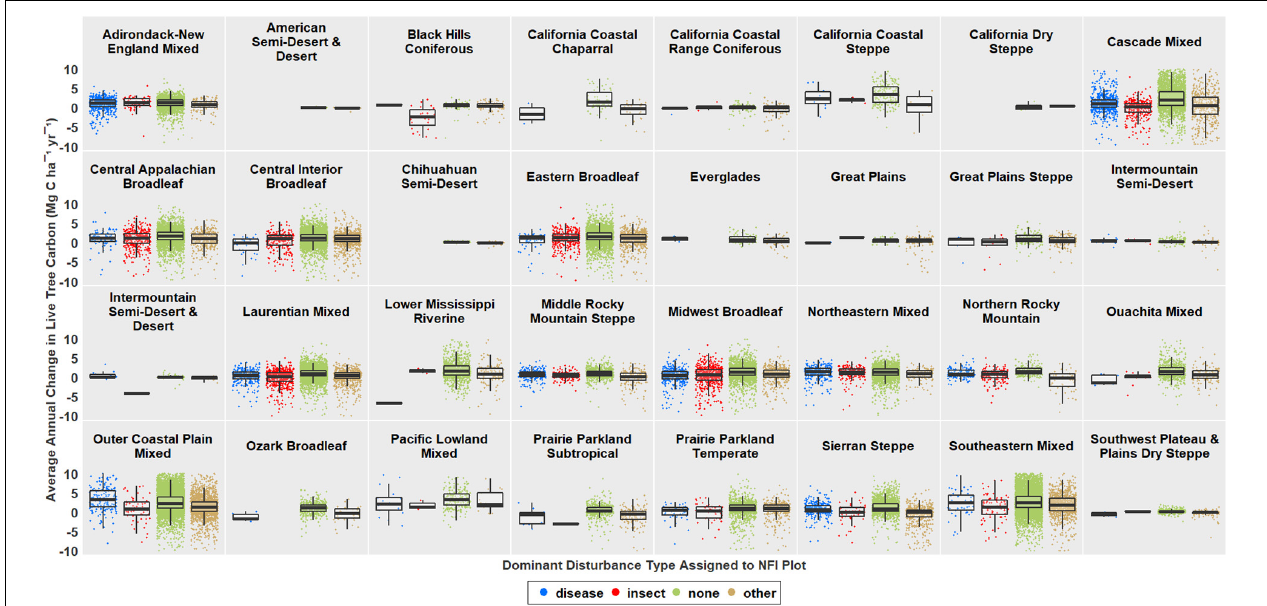
FIGURE 2 | Box and scatter plots of average annual change in live tree C (Mg C ha − 1 yr − 1 ) by dominant disturbance type assigned to NFI plots in 32 ecoprovinces of the contiguous US. Scatterplots show average annual change in live tree C for individual NFI plots by dominant disturbance type. Box plots show medians and interquartile ranges by dominant disturbance type with error bars representing 95% confidence intervals. 693 outlier NFI plots (i.e., over three standard deviations from the mean) were removed from this figure in order to facilitate visualization of differences between dominant disturbance